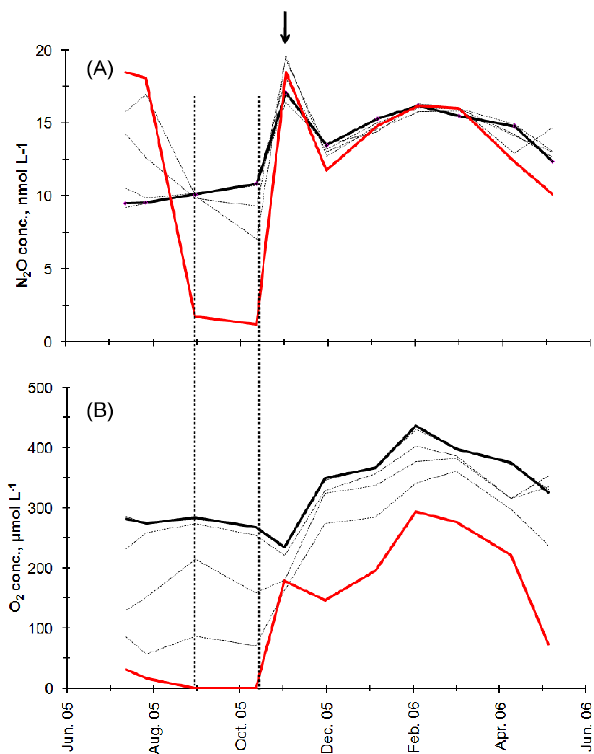
Fig. 8. Variability of N 2 O (A) and O 2 (B) at Boknis Eck time se- ries station in the western Baltic Sea from July 2005 to May 2006. The hypoxic/anoxic event is marked by vertical dashed lines. Con- centrations at 1m and 25m are highlighted with bold black and red lines respectively. The thin dashed lines represent sampling depths of 5, 10, 15 and 20m. The arrow marks the measurements made after the ventilation event in November 2005. Data are from Schweiger